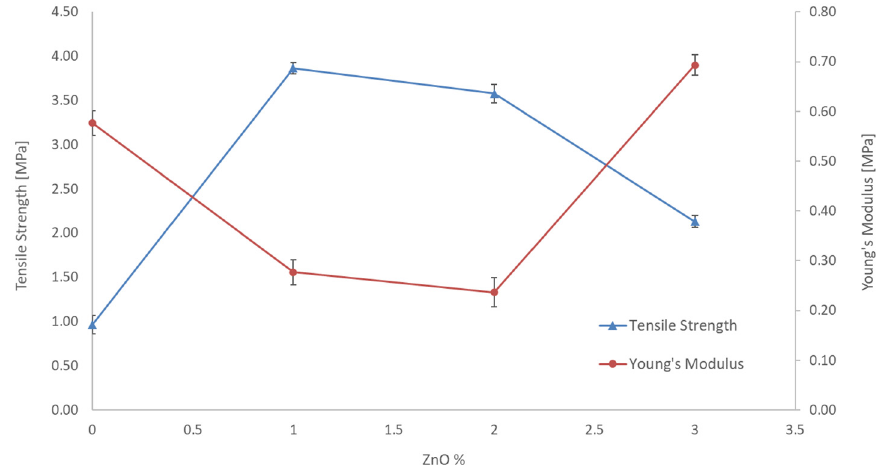
Figure 6. Tensile strength and Young’s modulus of the blended membranes prepared with a CA concentration of 10 wt%.